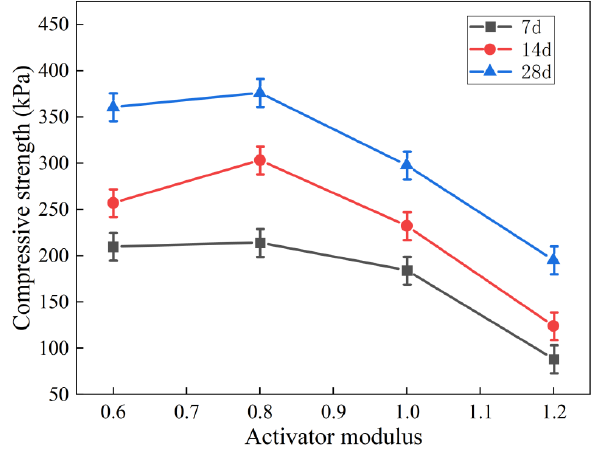
Figure 2. UCS of stabilized soils with different alkali activator modulus.